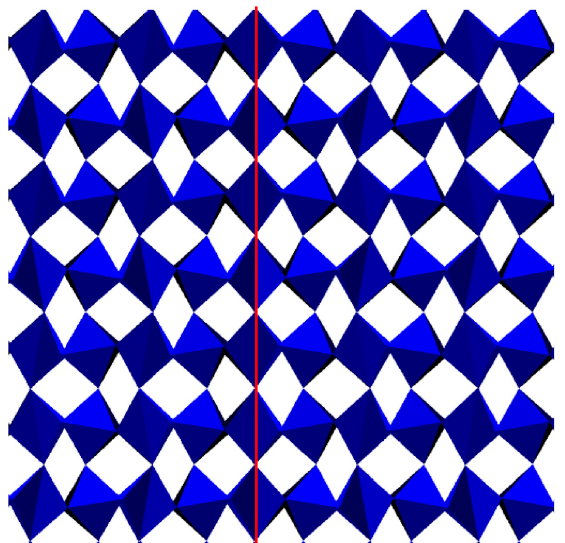
Figure 2. A snapshot of the TiO 6 octahedral tilts in the vicinity of the twin wall (vertical red line). Notice the change of the tilting angles across the boundary [18].